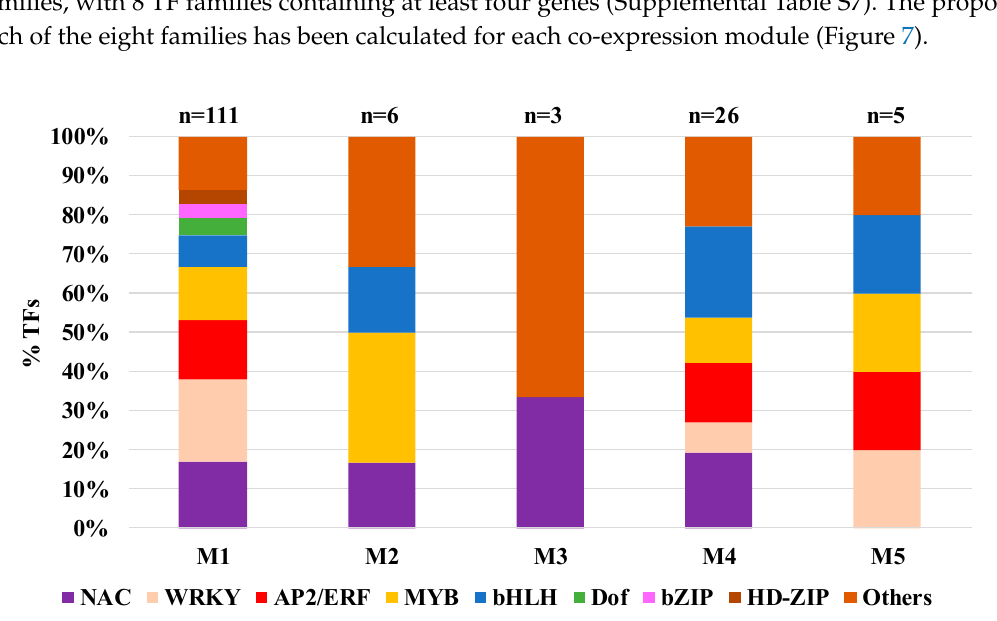
Figure 7. Proportion of (transcription factors) TFs per co-expression module. ‘n’ indicates the number of TFs for each module.